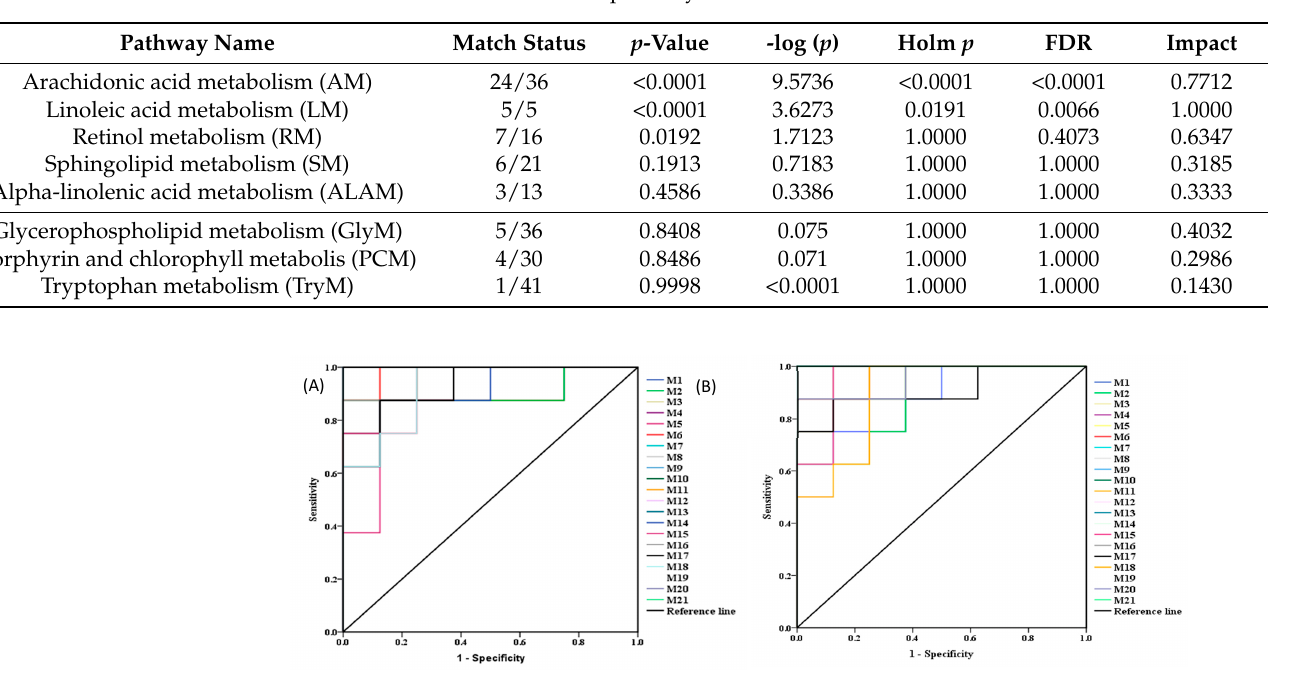
Table 7. The results from metabolic pathways of differential metabolites.